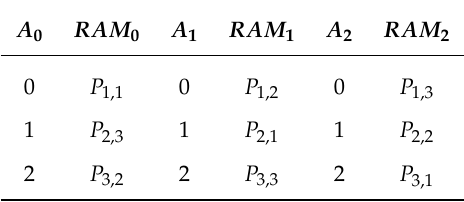
Table 2. Memory contents and internal address position of P matrix elements in RAM memory blocks used in a matrix of size N = 3, in circulant